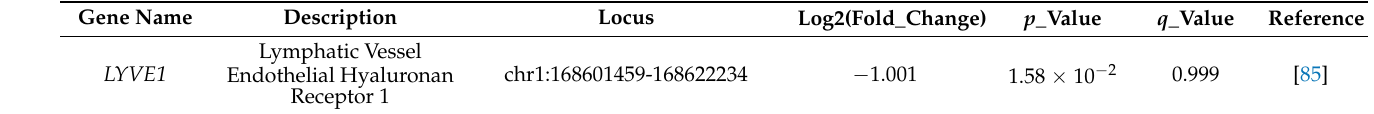
Table 2. Down-regulated genes in NK-5962-treated